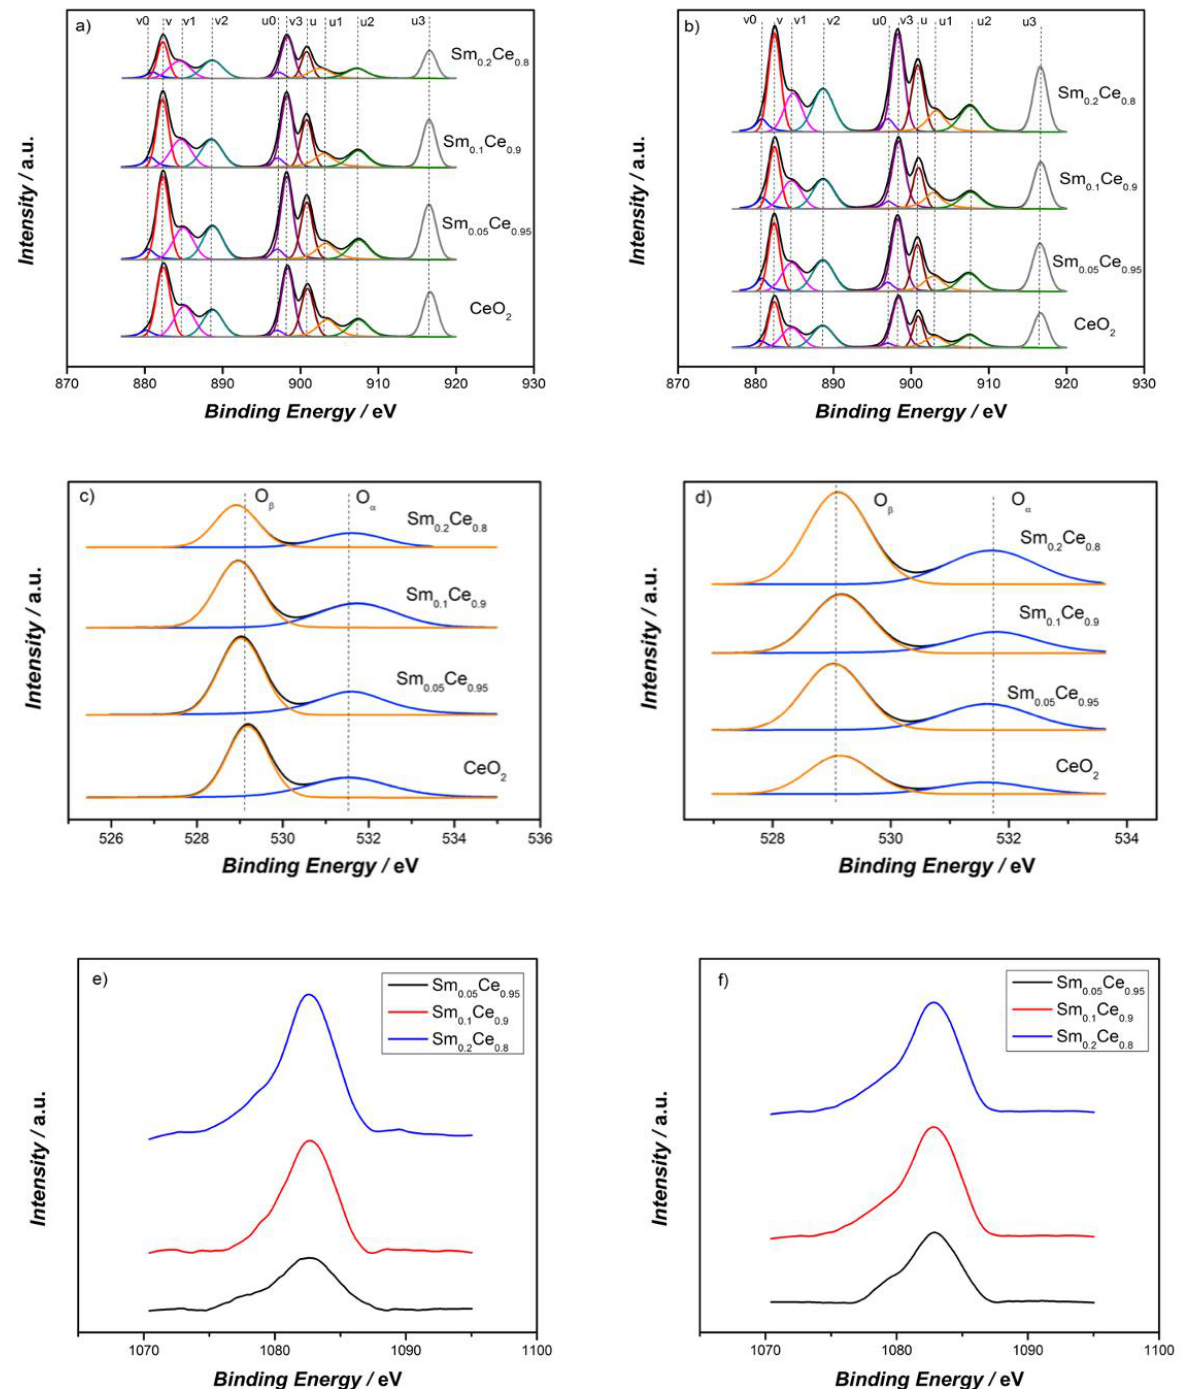
Figure 3. XPS results of ( a ) Ce3d of fresh catalysts, ( b ) Ce3d of spent catalysts, ( c ) O1s of fresh catalysts, ( d ) O1s of spent catalysts, ( e ) Sm 3d5/2 of fresh catalysts, ( f ) Sm 3d5/2 of spent catalysts. The peaks around 1082.6 eV in the Sm 3d5/2 spectra confirm that Sm is present as a +3-oxidation state in the catalyst, which agrees with the literature [48,49]. The surface ratio of Sm/Ce was calculated through XPS results. For fresh catalysts, the ratios are 0.059, 0.122, and 0.342, for 5%, 10%, and 20% Sm doping, respectively. Compared to the stoichiometric ratios of 0.053, 0.111, and 0.25 for 5%, 10%, and 20% Sm doping, respectively, the fresh catalysts show slightly higher values, indicating there is an enrichment of Sm on the detected surface of these catalysts. For spent catalysts, the Sm/Ce are 0.068,